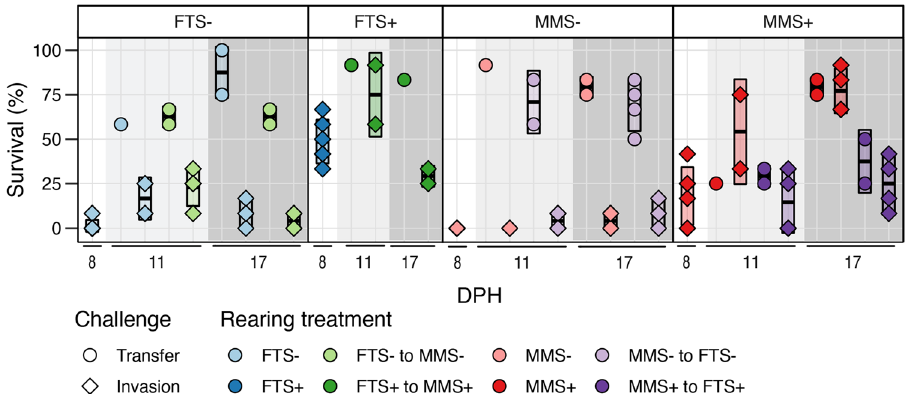
Figure 5. Percent of surviving larvae one day after the transfer and invasion challenge tests at various DPH. Samples are organized based on the initial rearing treatment. Colours indicate the overall rearing treatment. Boxplots represent mean survival ± SD for each rearing treatment at each sampling